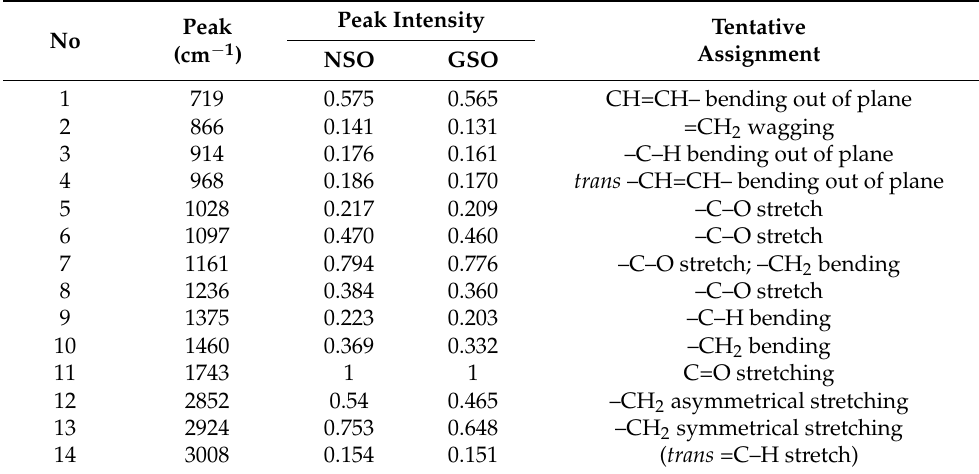
Table 2. The tentative peak assignment for the general FTIR spectra (600–3100 cm − 1 ) for NSO and GSO.